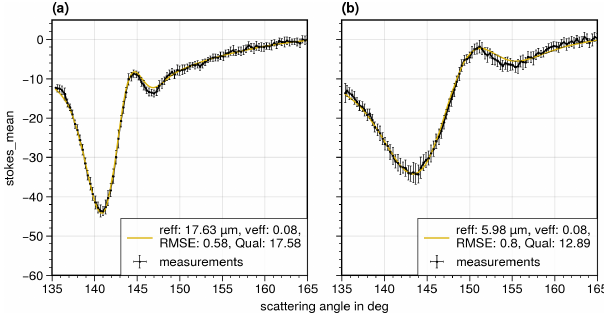
Figure 6. (a, b) The aggregated polarized radiance measurements of the green channel of two different target regions. The raw data are binned to a 0 . 3 ◦ resolution in the scattering angle (black dots connected by black lines). The error bars represent the standard de- viations of all original data points within a 0 . 3 ◦ bin. The yellow lines indicate the best-fitting simulations. The parameters r eff , v eff , RMSE, and Qual of the best-fitting simulations are shown in the boxes in the lower